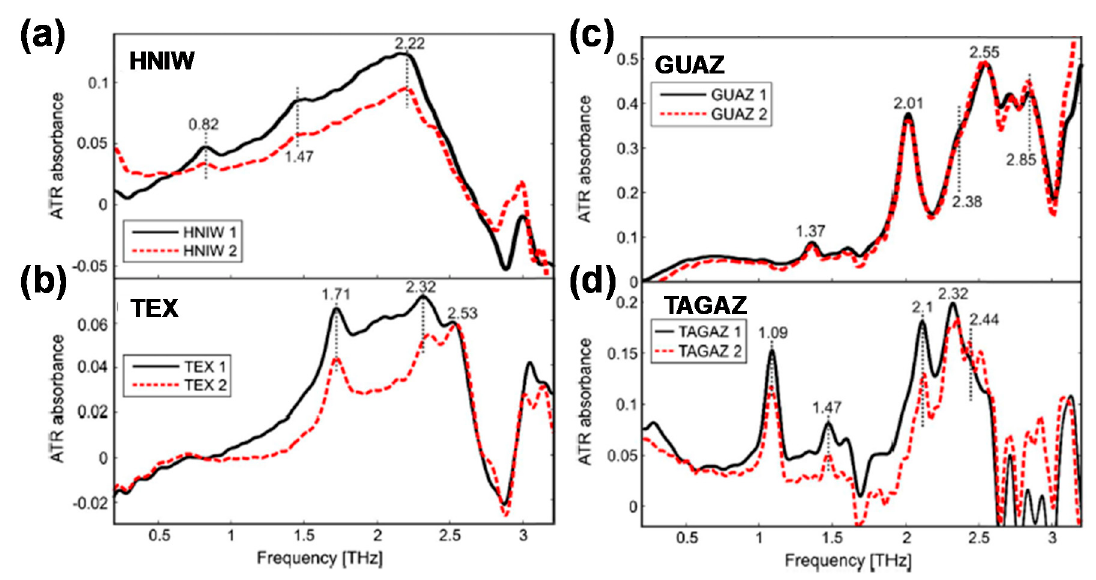
Figure 4. ATR absorbance of four explosives with distinguished character. ( a ) HNIW: Hexanitrohexaazaisowurtzitane, ( b ) TEX: Tetraoxadinitroisowurtzitane, ( c ) GUAZ: Guanidinium azotetrazolate, ( d ) TAGAZ: Triaminoguanidinium azotetrazolate. Reproduced with permission from [27], Copyright © 2018, The Optical Society.